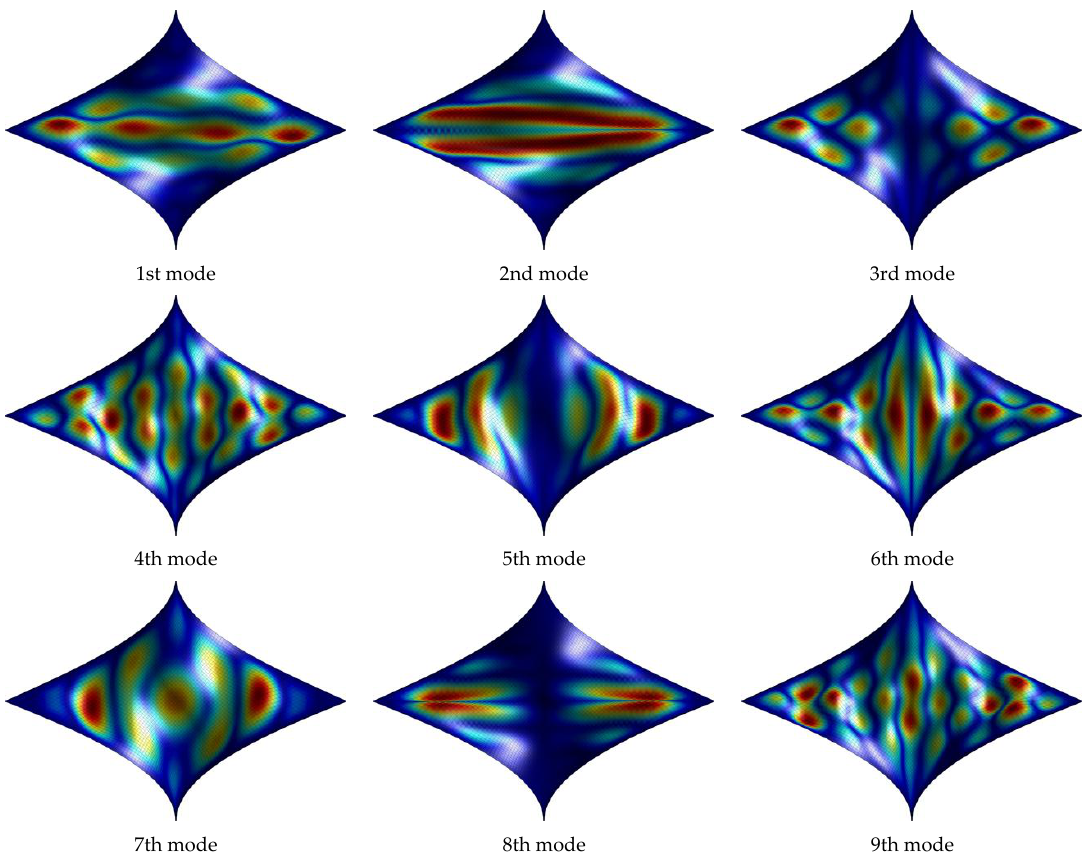
Figure 8. First nine mode shapes for a CCCC thin laminated helicoidal shell with ( 0/90/0/90 ) as lamination scheme.